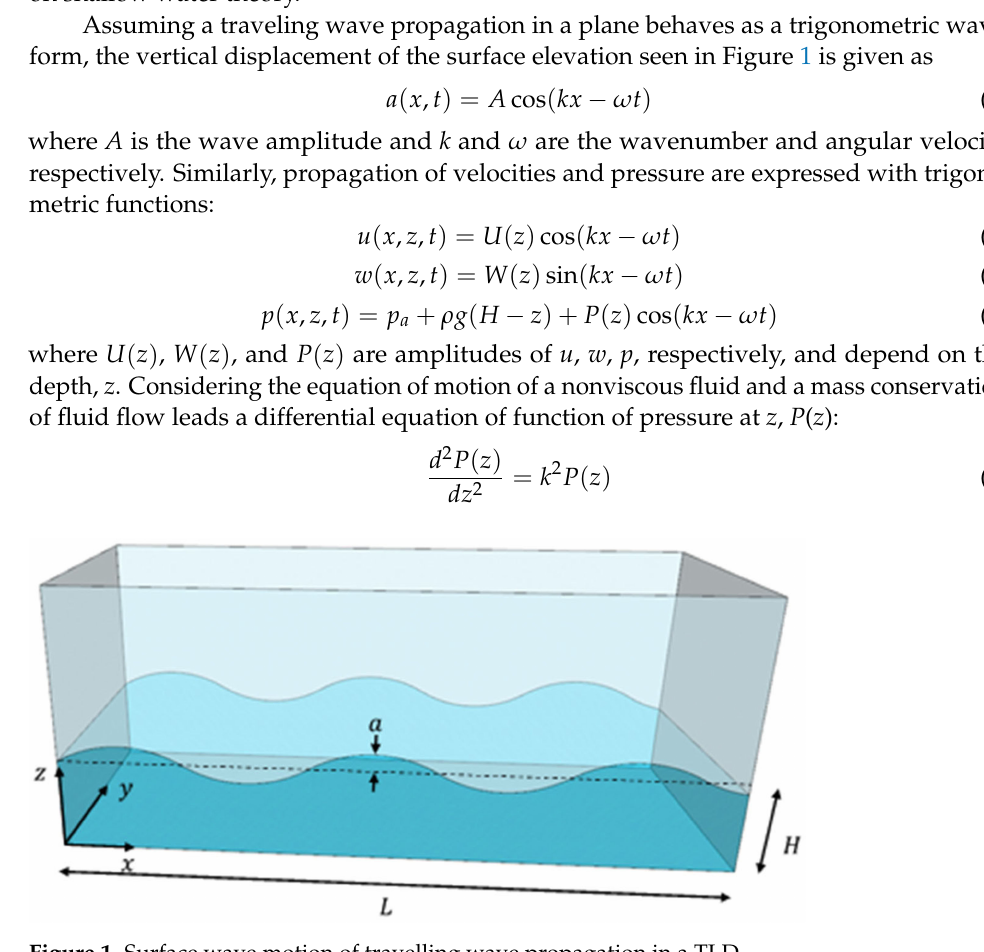
Figure 1. Surface wave motion of travelling wave propagation in a